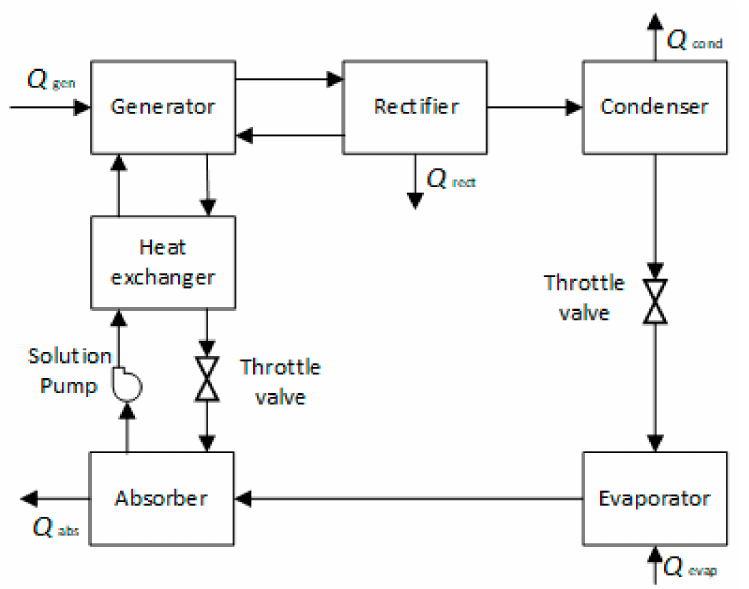
Figure 3. A schematic diagram of a vapour absorption system for a fishing boat. Figure adapted from